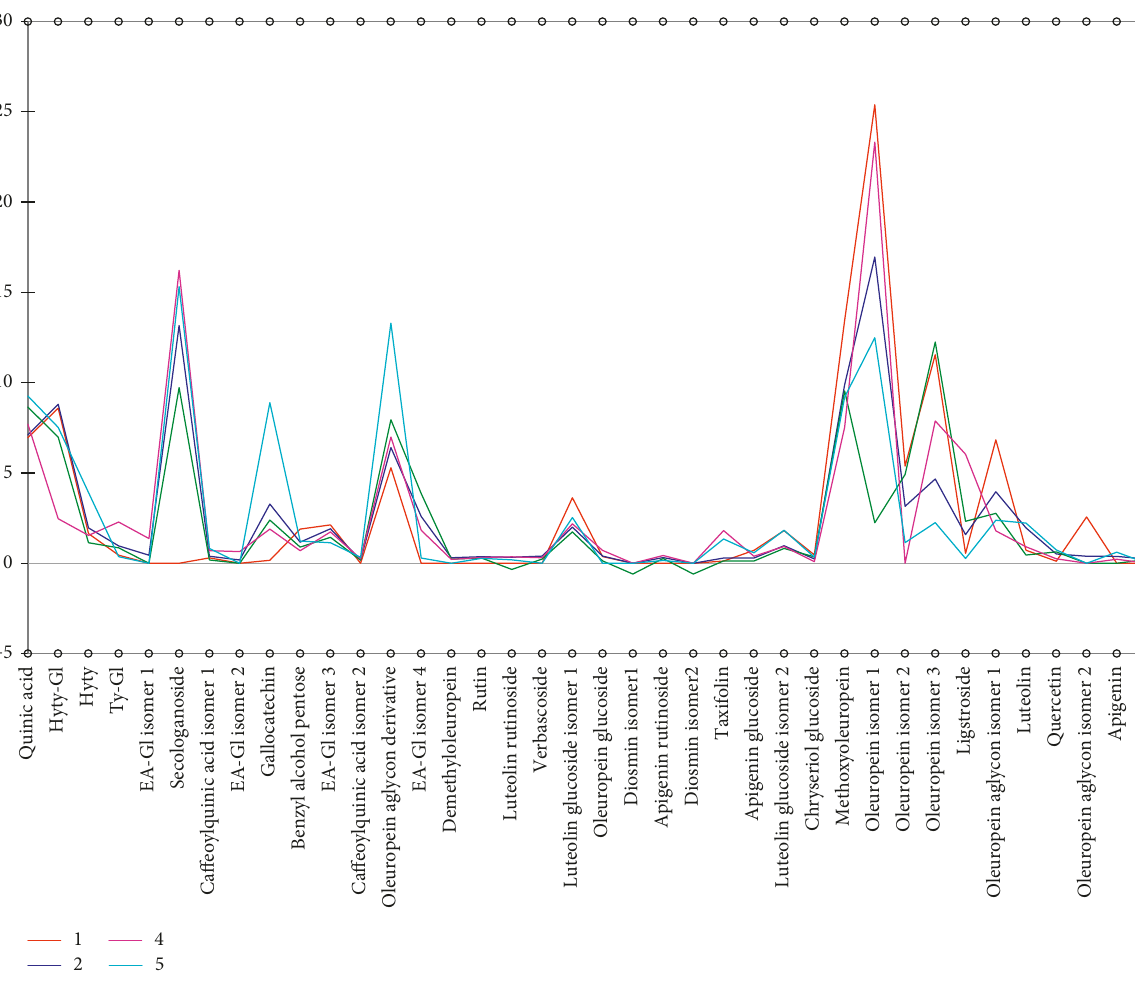
Figure 9: HCA groups’ profiles according to the phenolic composition. Groups: (1) Gabes; (2) Ghraiba, Kondar, Sidi Bou Ali, Teboulba; (3) El Hajeb; (4) Jelma, Zaghouan; (5)